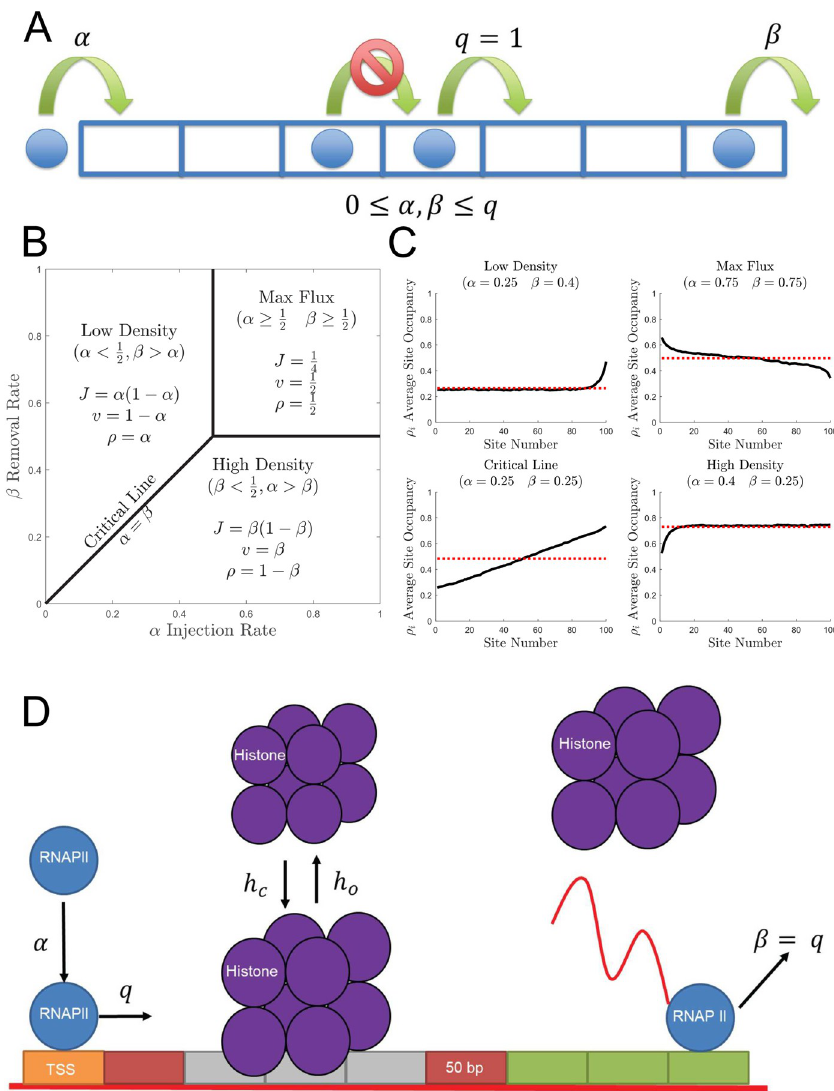
Fig 1. Extension of the canonical TASEP to include nucleosomes as dynamic defects. (A) Depiction of the canonical TASEP. Particles are injected into the first lattice site at rate α and advance with rate q = 1 when unobstructed by other particles. Particles are removed from the final lattice site at rate ß. (B) The canonical TASEP phase diagram in the α ß-plane with the fundamental relationships for J , ρ , and v summarized for each phase. (C) Simulated density profiles for each phase are shown by black lines, and dashed red lines indicate the mean-field theory prediction obtained for an infinitely long lattice. (D) Depiction of the proposed dynamic defect TASEP (ddTASEP) where periodically spaced nucleosomes function as extended-body dynamic defects. RNAPII bind the first lattice site (transcription start site, TSS) at rate α , RNAPII advances at rate q when unobstructed by other polymerases or nucleosomes. RNAPII is then released from the gene at the end of transcription at rate ß , which is set equal to q (ß = q). DNA in the nucleosome associated regions (containing 3 subsequent sites) unwraps from the nucleosome to the open conformation at rate h o and returns to the wrapped/closed state at rate h c when there are no polymerase present on the nucleosome associated sites. All lattice sites are 50 bp long.